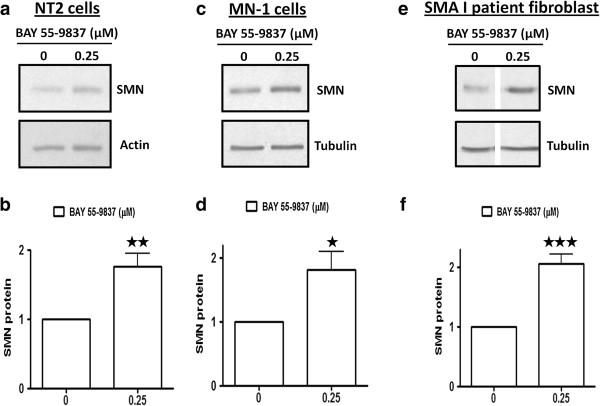
BAY 55-9837 treatment upregulates SMN protein in vitro. NT2, MN-1 and SMA I patient fibroblasts were treated with BAY 55-9837 (0.25 μM) and then harvested at 24 hours for western blot analyses. (a) Representative western blots showing the effect of BAY 55-9837 on SMN protein in NT2 cells. (b) Densitometric quantification of SMN protein relative to Actin (the ratio at control treatment was set as 1; mean + SEM (bars) of six independent experiments) are shown for NT2 cells. (c) Representative western blot showing effect of BAY 55-9837 on SMN protein in MN-1 cells. (d) Densitometric quantification of SMN protein relative to Tubulin (the ratio at control treatment was set as 1; mean + SEM (bars) of three independent experiments) are shown for MN-1 cells. (e) Representative western blots showing the effect of BAY 55-9837 on SMN protein in SMA I patient fibroblasts (all lanes were run on the same gel but were non-contiguous). (f) Densitometric quantification of SMN protein relative to Tubulin (the ratio at control treatment was set as 1; mean + SEM (bars) of five independent experiments) are shown for SMA I patient fibroblasts. *P < 0.05; **P < 0.01; ***P < 0.001, t-test.